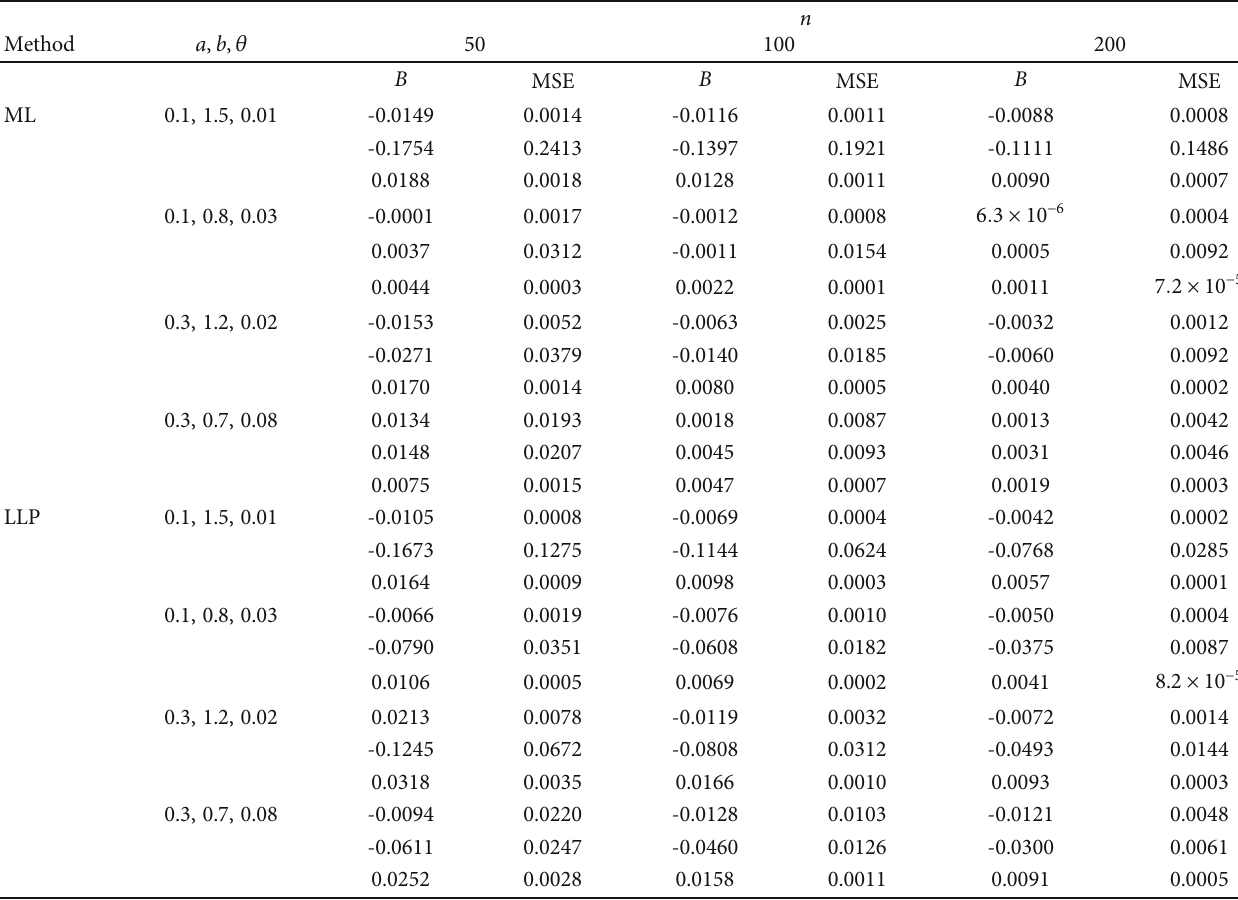
and MSE in the fi rst a a